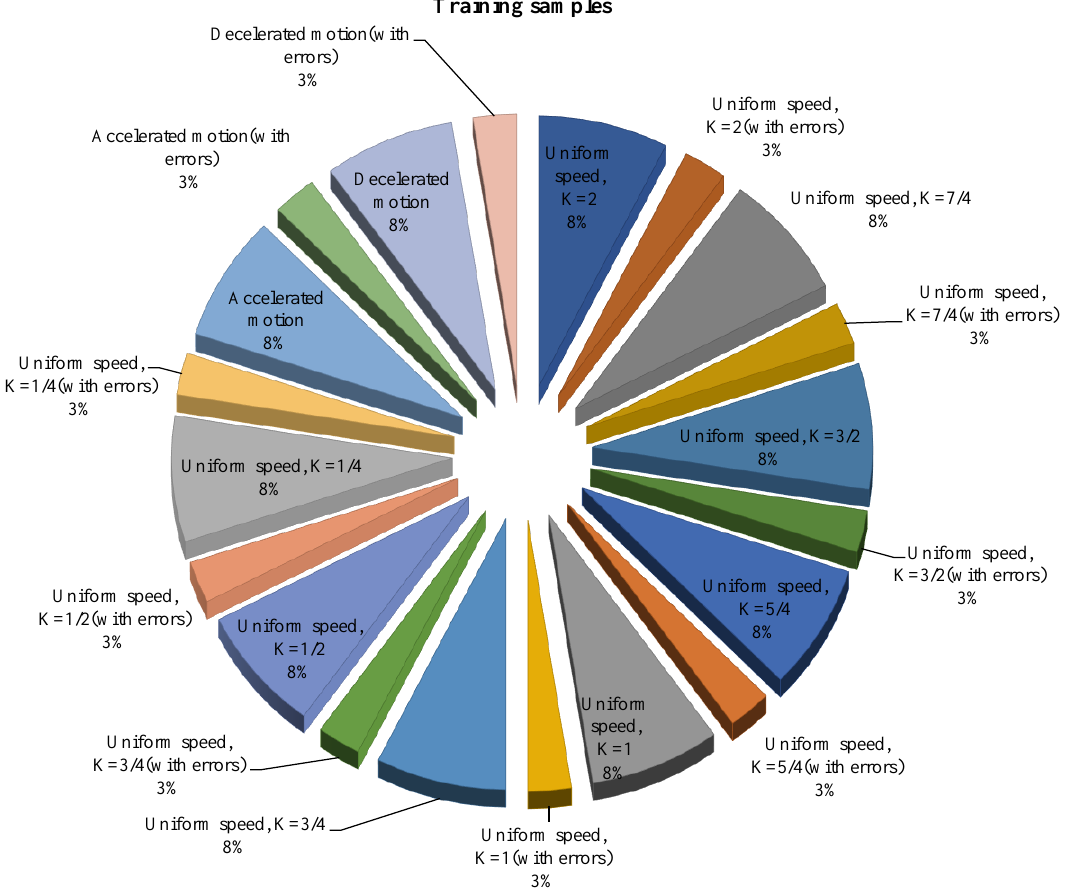
Figure 12. The distribution of training data for the neural network.